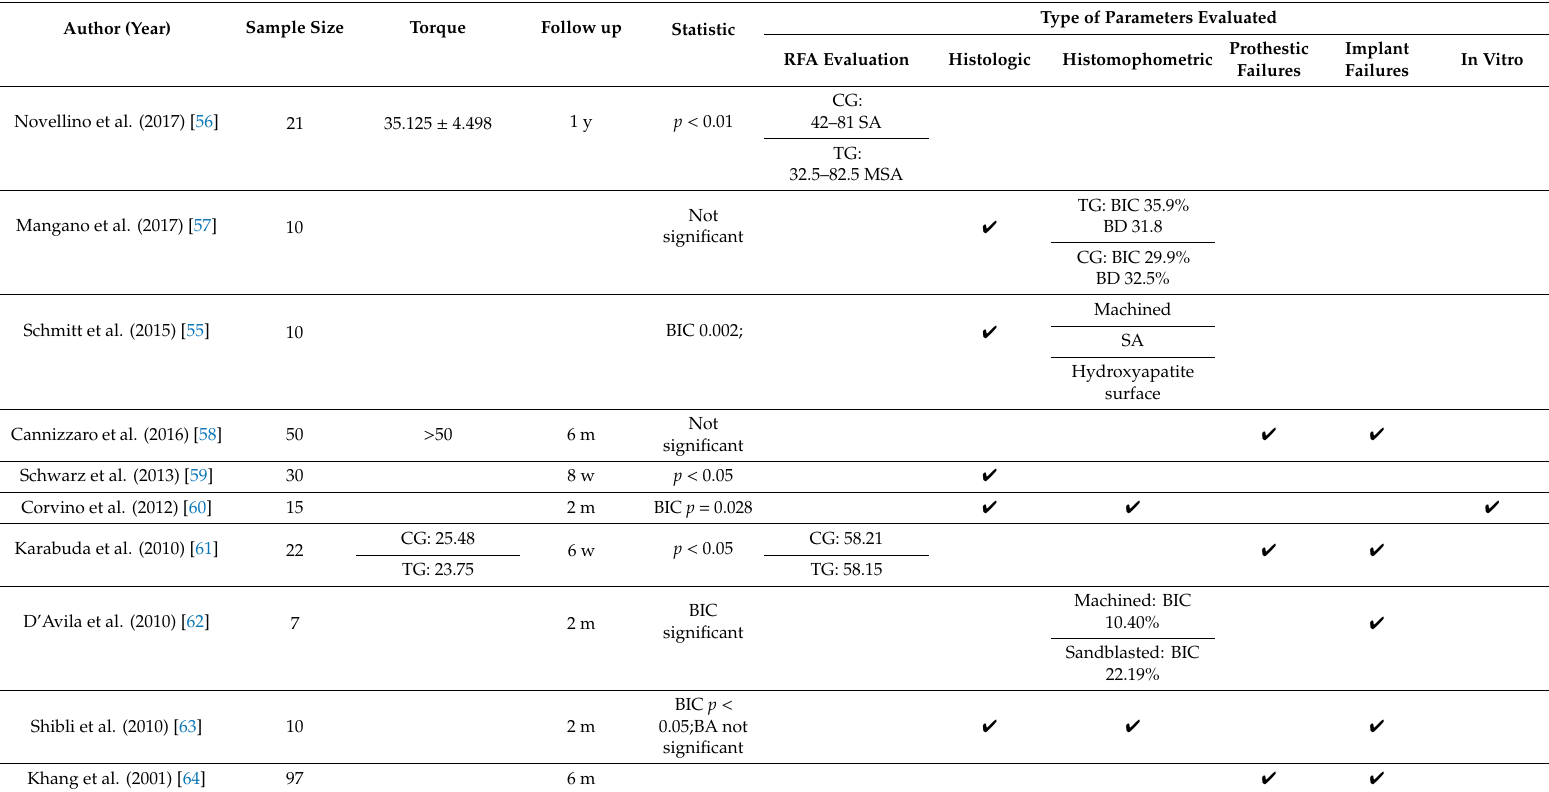
Table 1. Selected studies evaluated parameters. ( (cid:52) = histologic examination